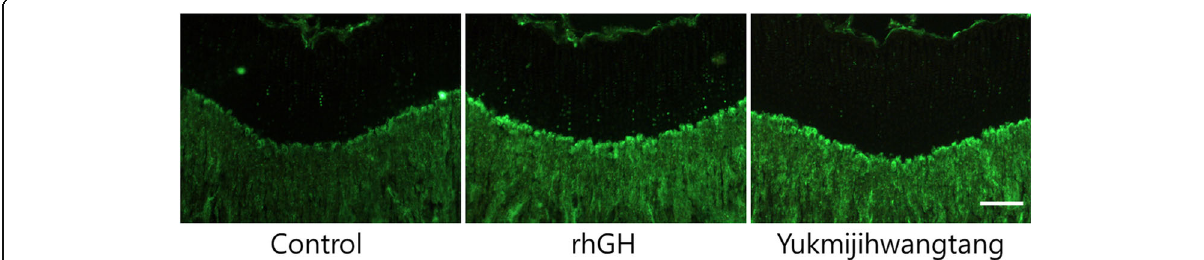
Fig. 4 Representative images of 5-bromo-2 ’ -deoxyuridine (BrdU)-labeled chondrocytes in the growth plates in the proximal tibia. The control group received distilled water, the rhGH group received 20 μ g/kg rhGH and the YJT group received 300 mg/kg YJT. Green : BrdU-labeled chondrocyte. Scale bar=100 μ